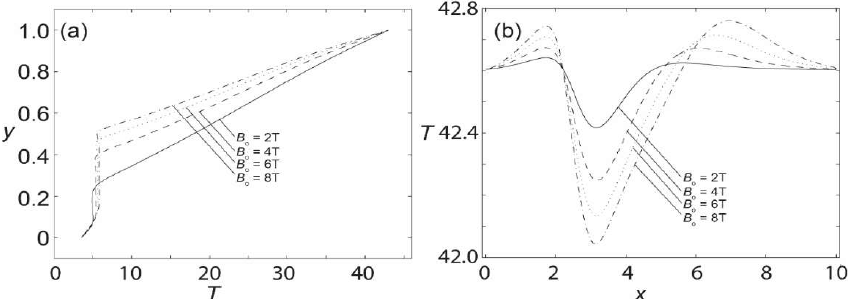
Figure 7. Temperature profiles at ( a ) x = 3.5; and ( b ) mid-span of the channel when subjected to various magnetic field intensities with Re = 250.